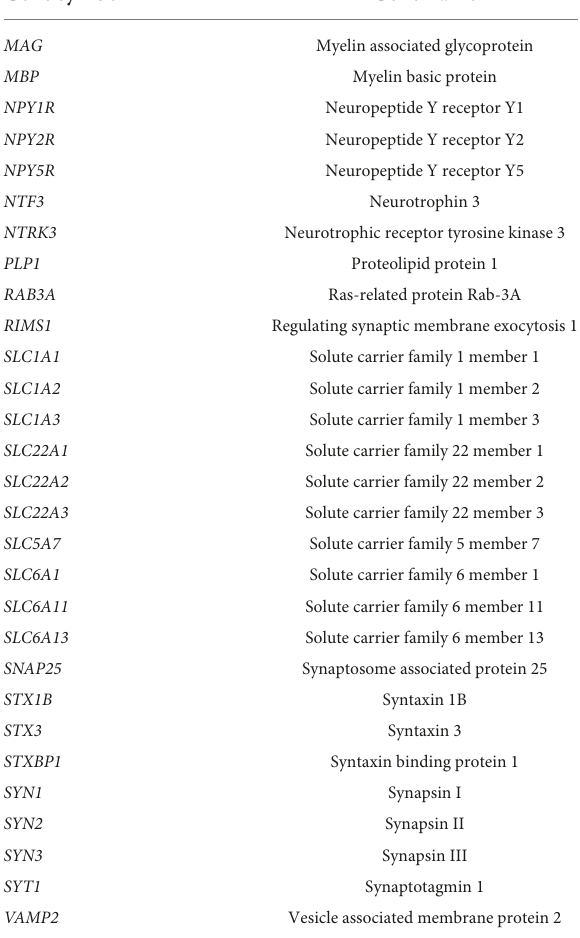
( Figure 1 ). The largest variation in gene expression profiles of brain tissue samples was seen in the principal component 1, with samples primarily grouped by brain region. Gene expression profiles in the striatum were distinct from the other areas, whereas the hippocampus and prefrontal cortex profiles overlapped to some extent. A secondary grouping of samples based on milk treatments was observed for the striatum for caprine and ovine milk-fed pigs, but this grouping was less evident for the hippocampus and prefrontal cortex.